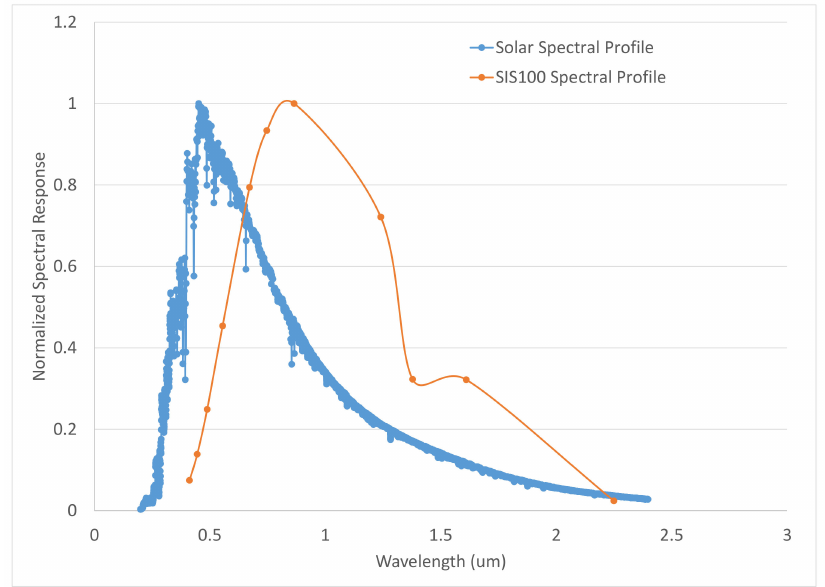
Figure 3. A comparison of the on-orbit solar spectral irradiance profile and the SIS100 radiance profile. The OOB Relative Spectral Response (RSR) contributions are not weighted the same in on-orbit and prelaunch